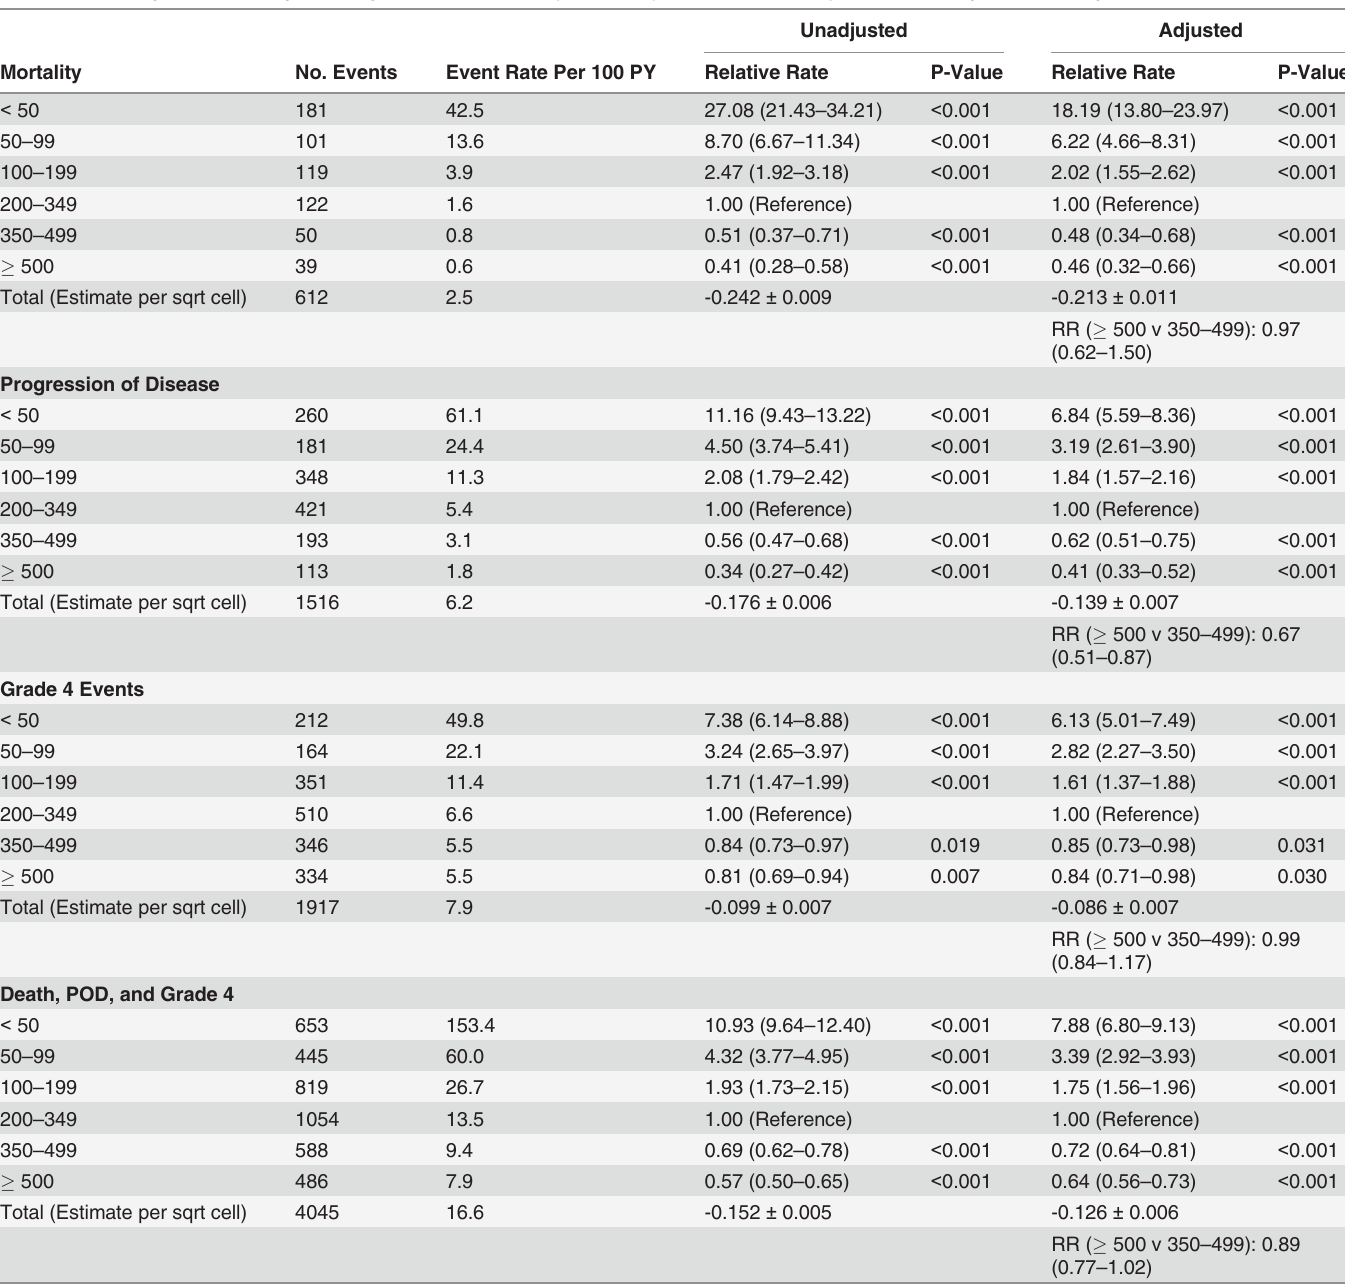
Table 3. Mortality and Morbidity Rates by Latest CD4 Count (cells/mm 3 ) for Phidisa Participants: Morbidity and Mortality